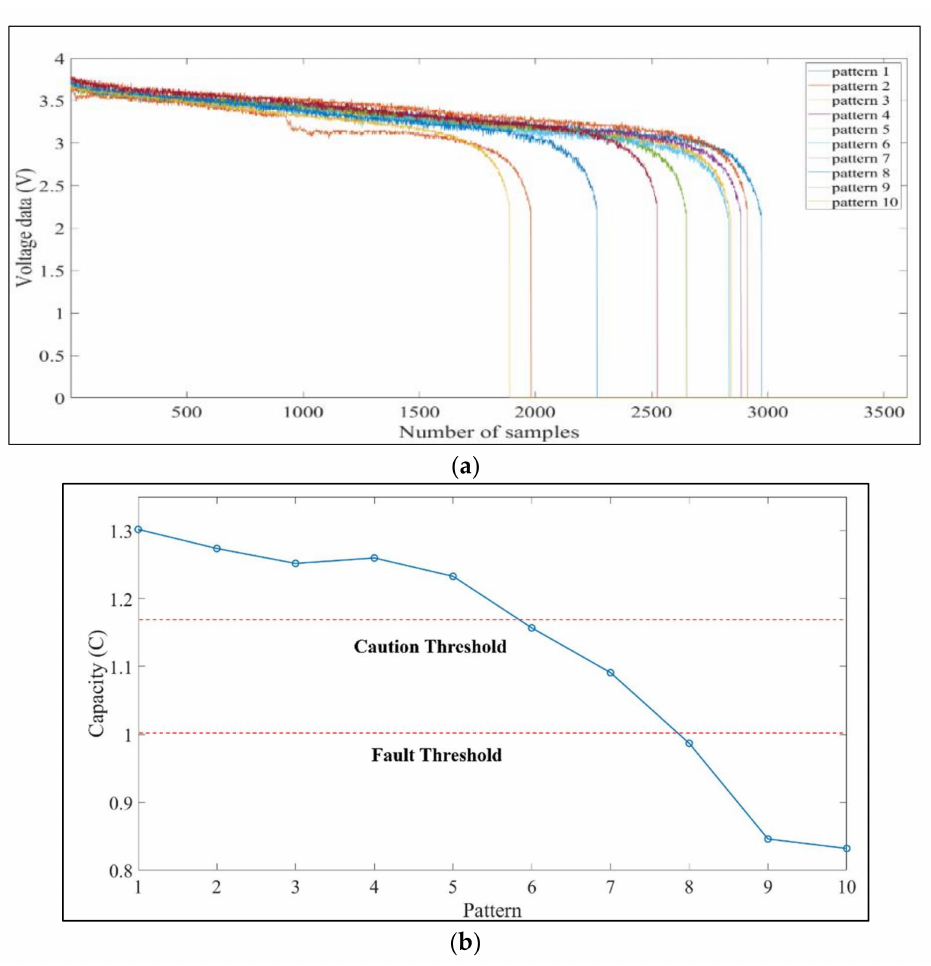
Figure 7. ( a ): Battery discharge data for learning. ( b ): Graph of battery’s remaining useful life determined using the current sensor in the experimental